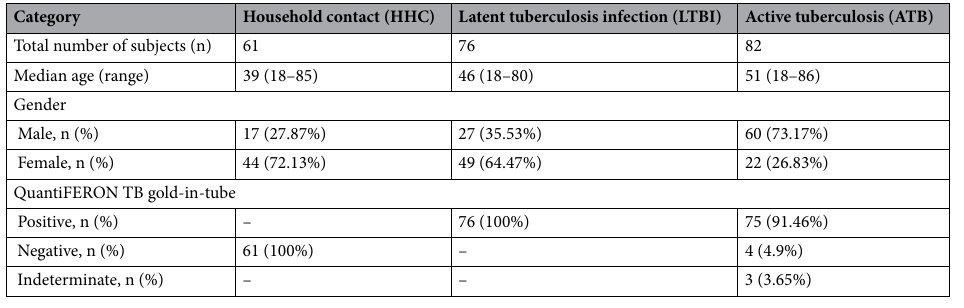
Table 2. Characteristics of subjects for humoral immune response